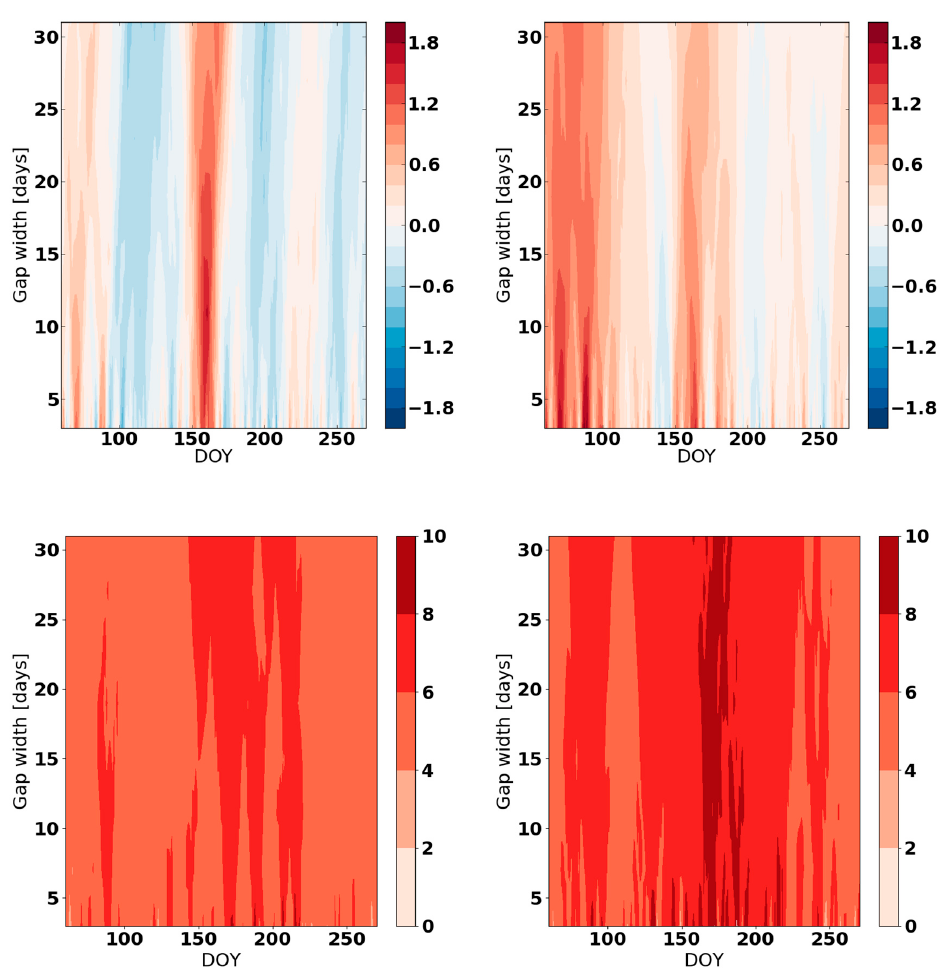
Figure A1. B DEB ( top , left panel ), B ERA5 ( top , right panel ), U(B) DEB ( bottom , left panel ), and U(B) ERA5 ( bottom , right panel ) calculated using data for DOY 60-273 2014 in Kikinda.